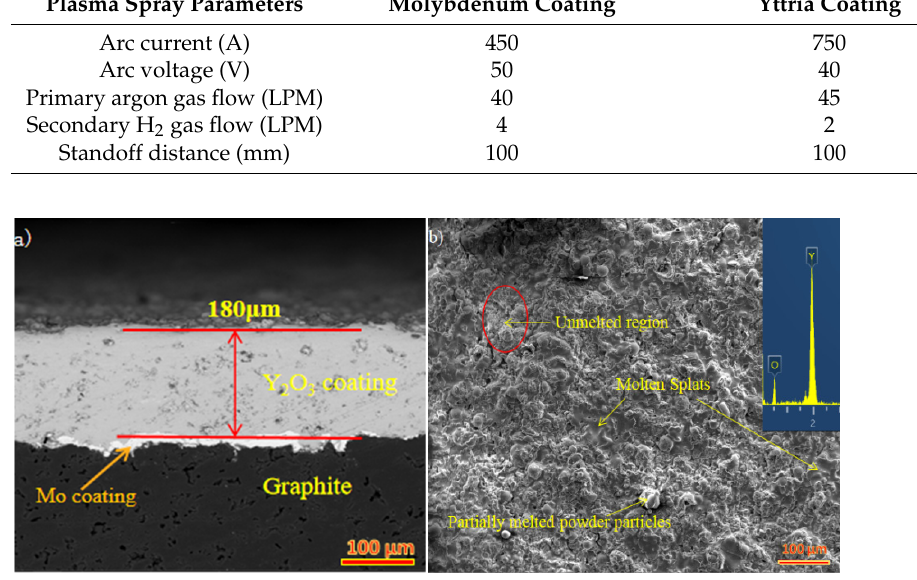
Figure 1. ( a ) Sectional view of coating; ( b ) microstructure of coating with EDS over the entire area.